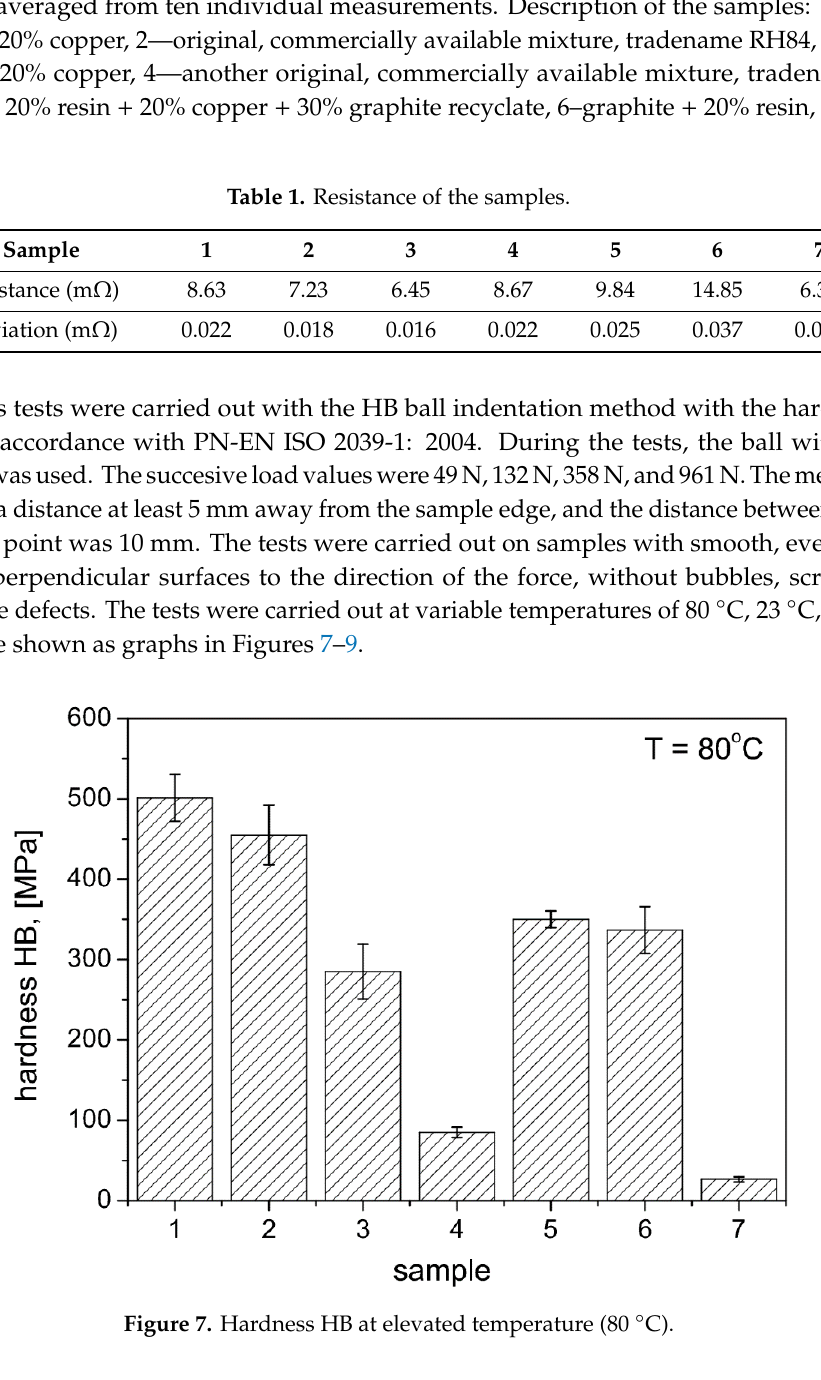
Figure 7. Hardness HB at elevated temperature (80 °C).